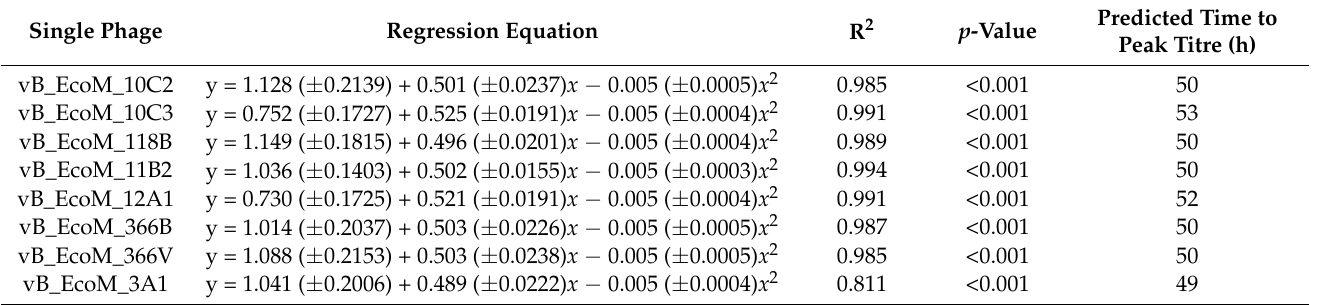
Table 2. Relationship between titres phage cocktails ( y ) and in vitro ruminal incubation time ( x ). Phage Cocktail Regression